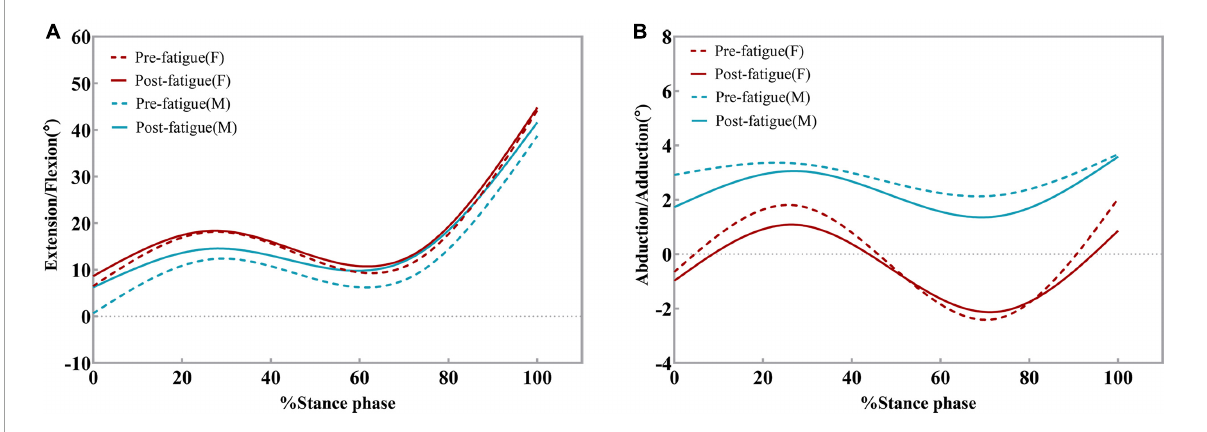
FIGURE7 Ensemble average knee kinematics for the dominant limb for all male and female participants. Changes in knee flexion angles (A) and knee adduction angles (B) pre-fatigue and